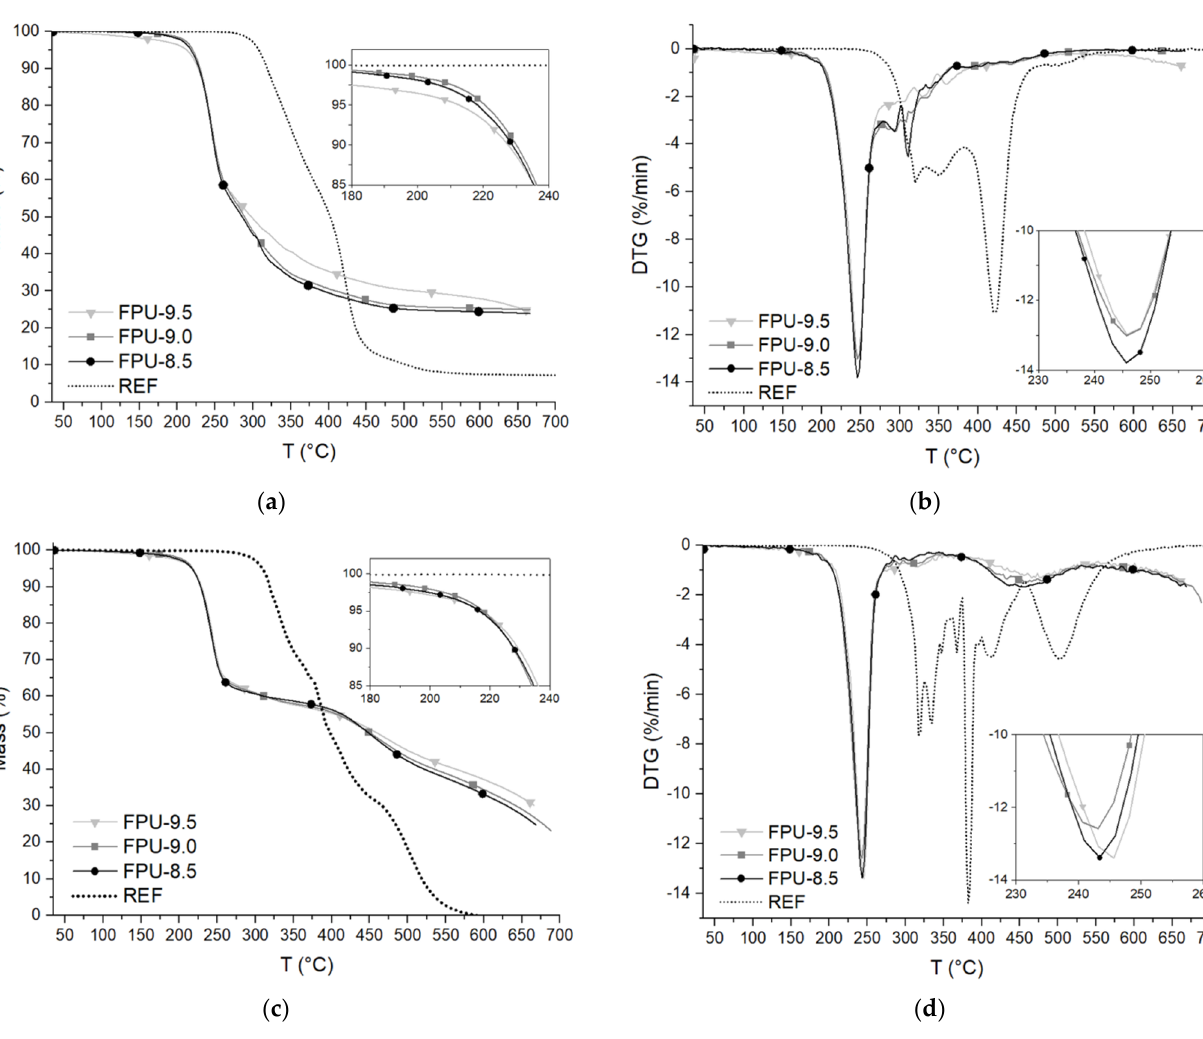
Figure 5. Thermogravimetric analysis results: TGA curves for materials tested in the ( a ) nitrogen and ( c ) air atmospheres and DTG curves for materials tested in the ( b ) nitrogen and ( d ) air atmospheres.